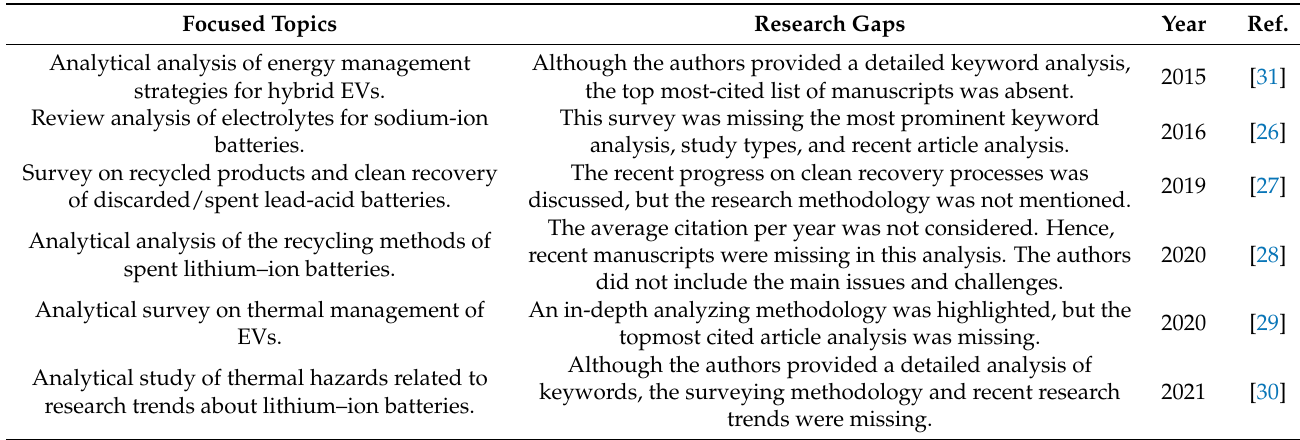
Table 1. Analytical analysis manuscripts and their